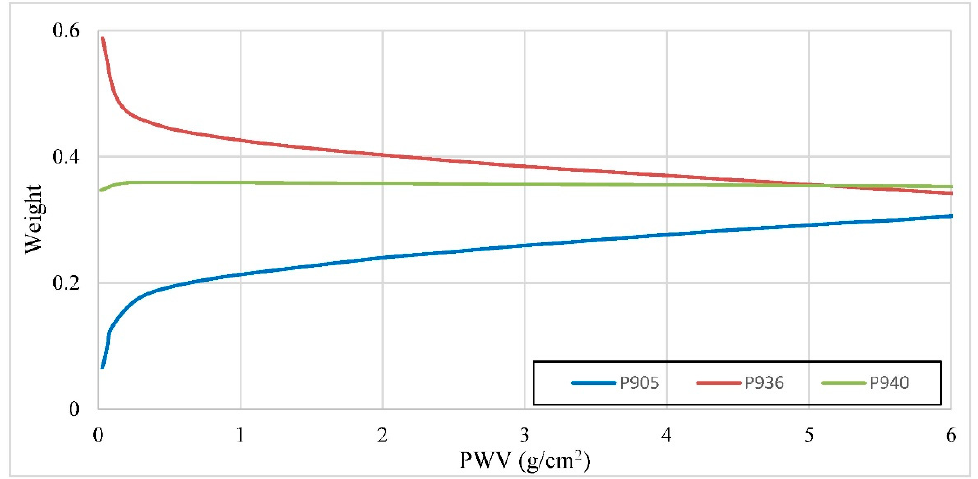
Figure 10. The weights of three original MERSI-2 PWV datasets participating in fusion used by Wang et al. [22].